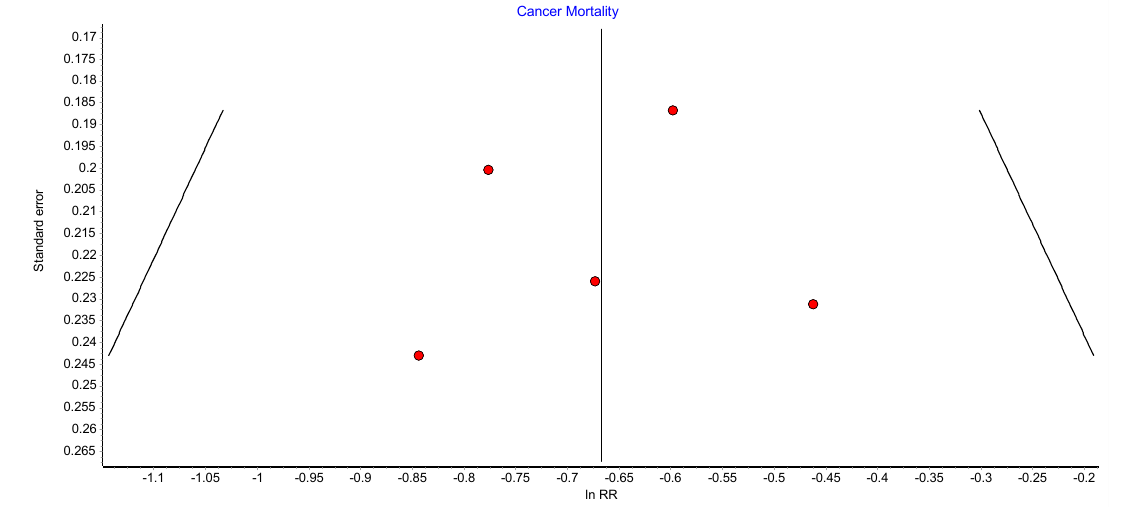
Figure A3. Cancer-related mortality RE funnel plot.